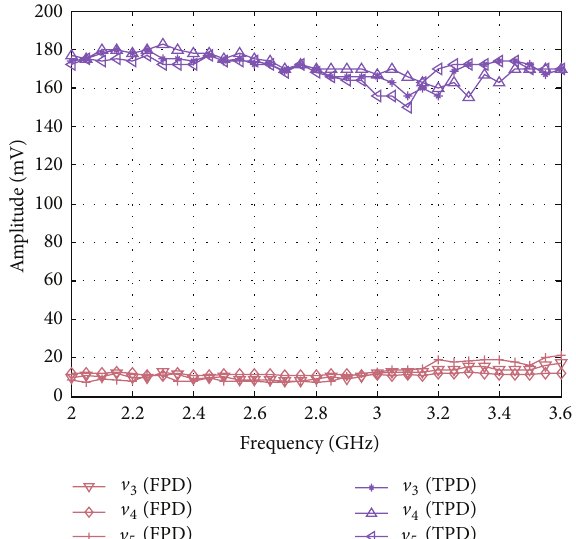
Figure 4: Measured output voltage amplitudes for FPD and TPD architectures without 𝐼/𝑄 regeneration circuit ( 𝑃 −25 dBm, and Δ𝑓 = 10